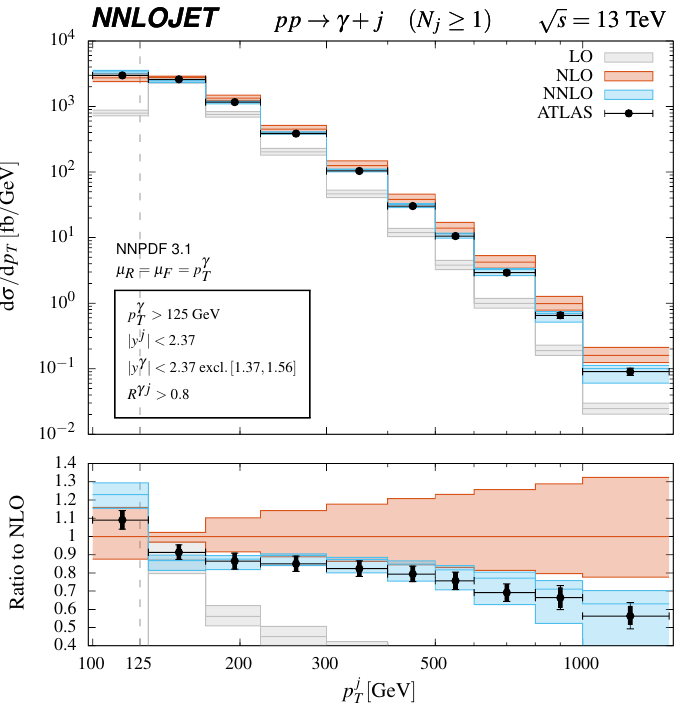
Figure 12 . Transverse momentum distribution of the leading jet in photon-plus-jet events, at LO, NLO and NNLO. The grey dashed line marks the cut on the p T of the photon, the recoil of which mostly goes into the leading jet. The predictions are compared to ATLAS data